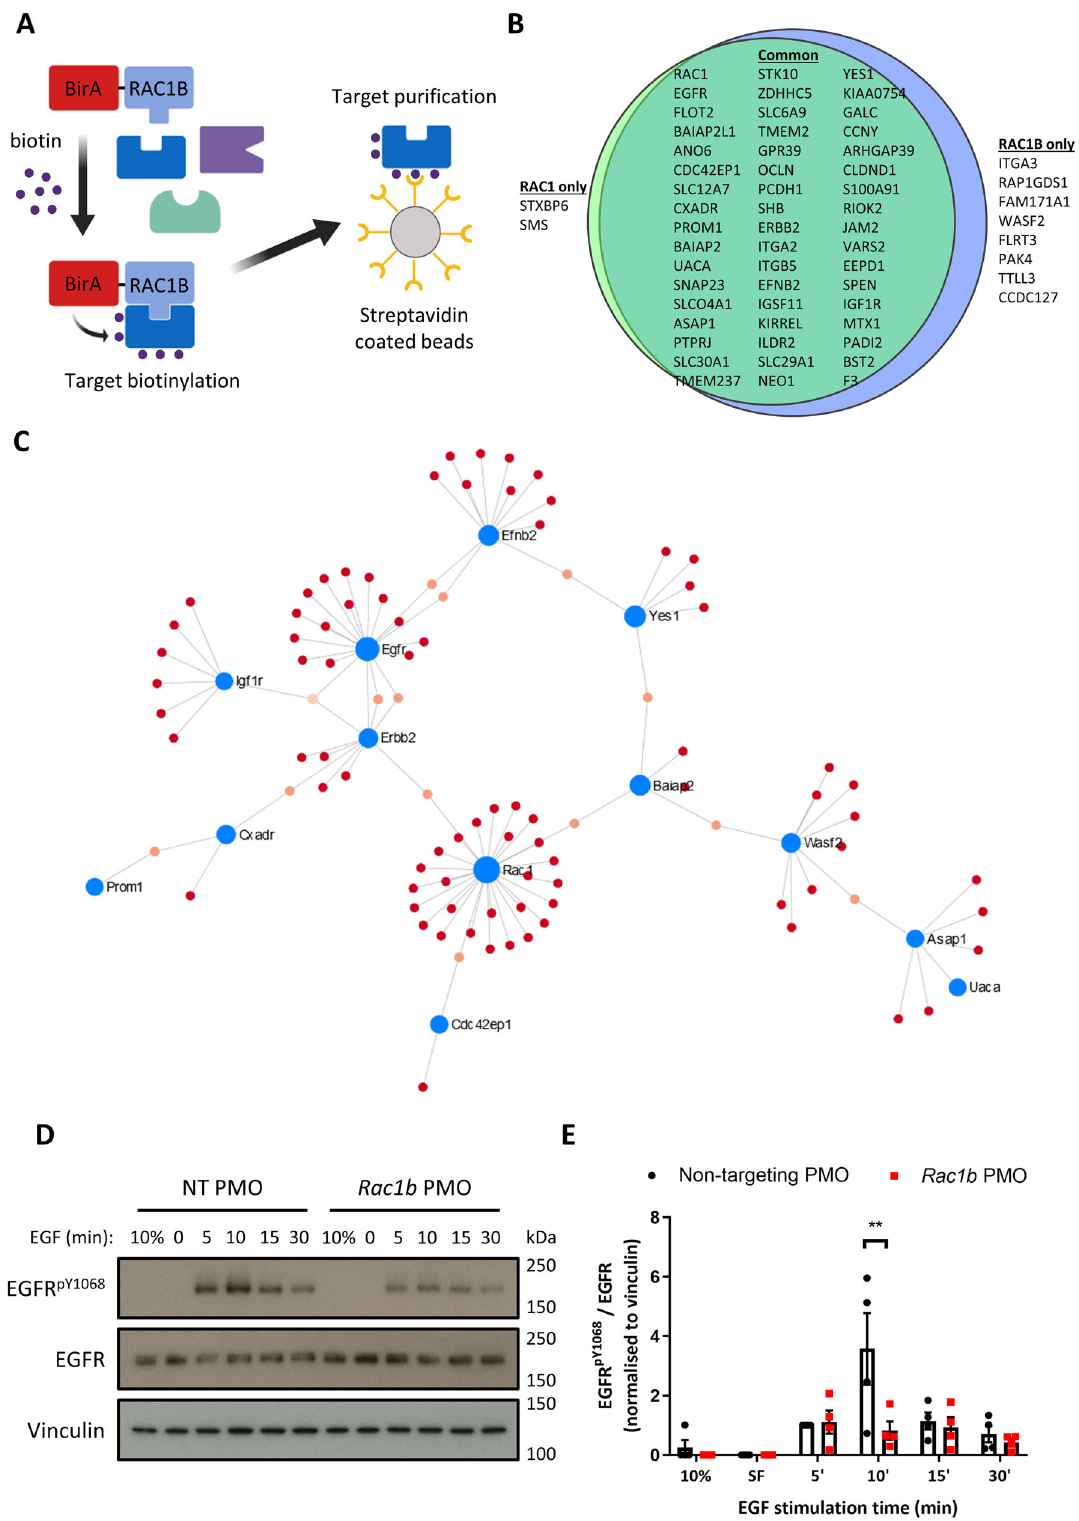
Fig. 5 RAC1B interacts with multiple membrane-bound receptor tyrosine kinases. A Schematic of BioID protocol. B Venn diagram outlining RAC1 and RAC1B interacting proteins identi fi ed by MS and the overlap between the interactomes. C Network analysis of the RAC1/RAC1B interactome. D CMT93 cells were treated with NT or Rac1b PMO, serum-starved and then stimulated with EGF for 5, 10, 15 or 30 min before analysis by western blotting for EGFR pY1068 , EGFR and Vinculin (sample control blot). Representative blots shown. E EGFR pY1068 band densitometry relative to EGFR (normalised to Vinculin) of 4 replicate time course experiments (data are presented as mean ± SEM; ** P = 0.002; two-way ANOVA with Tukey multiple correction; n = 4v4). Source data are provided as a Source Data fi